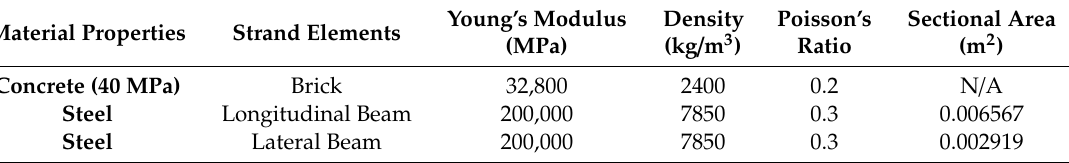
Table 3. Strand7 input material